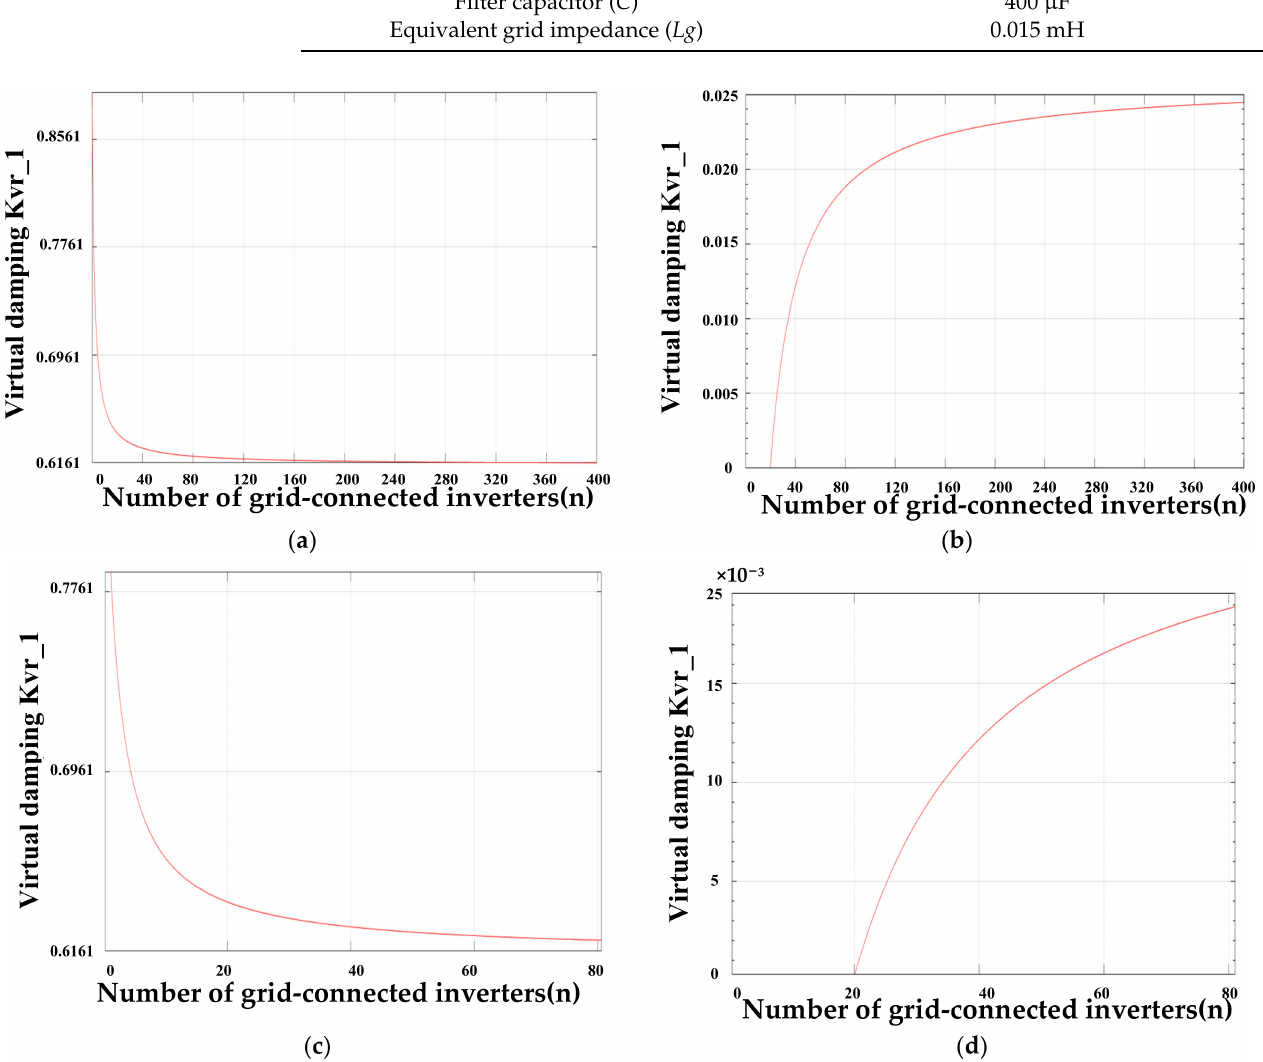
Figure 13. Virtual damping comparison without DOB; ( a ) virtual damping figure without DOB; ( b ) virtual damping figure with DOB; ( c ) partial enlarged view; ( d ) Partial enlarged view after adding the